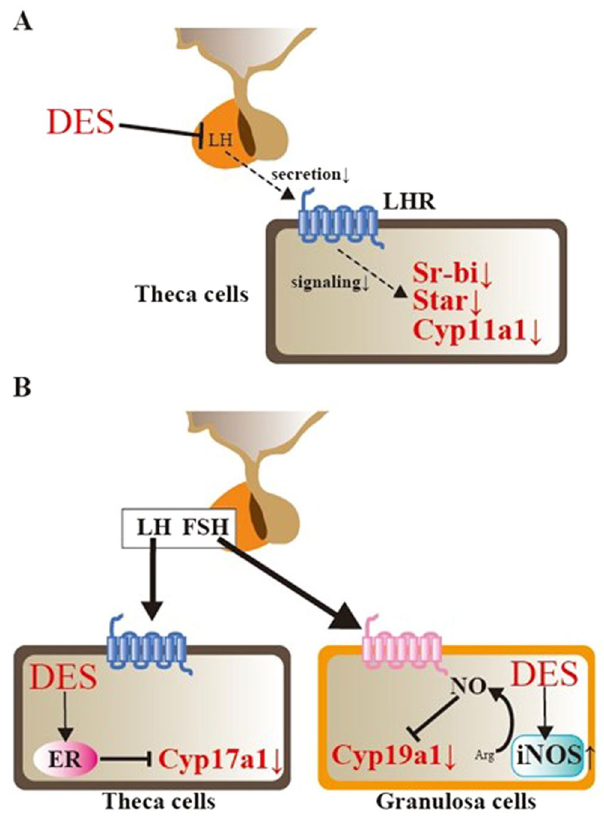
Figure 8. Proposed model of the effects of DES on ovarian steroidogenesis. ( A ) During the initial phase, DES inhibits both LH secretion from the pituitary and expression of steroidogenesis-related genes in theca cells. ( B ) After recovery of LH/LHR signaling, theca cell androgen and granulosa cell estrogen production continued to be suppressed by reduced Cyp17a1 and Cyp19a1 expression via direct actions of DES on